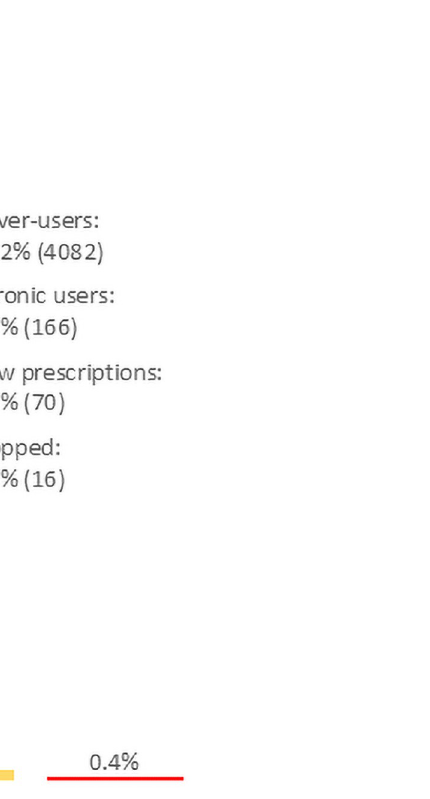
Fig 1. Proportion of chronic levothyroxine